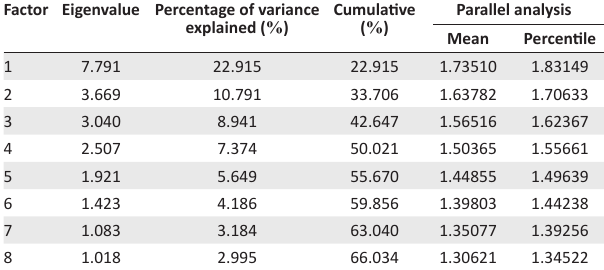
TABLE 3: Eigenvalues and parallel analysis